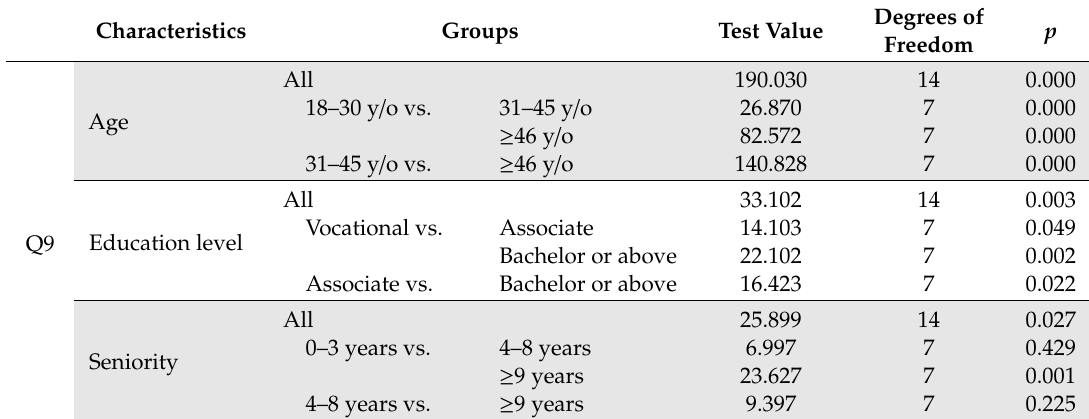
Table 5. Di ff erences between age, education level, and seniority groups for Q9 (barriers).